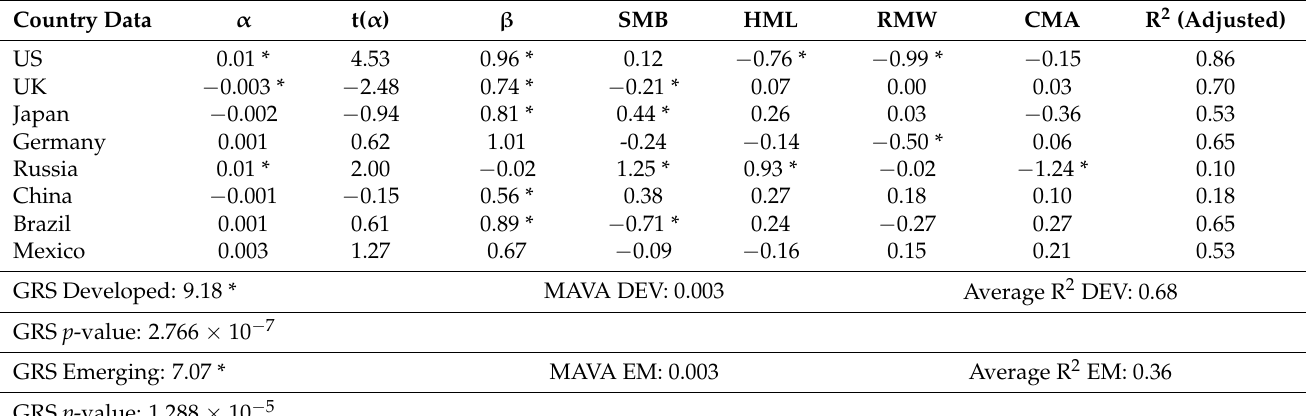
Table 1. Fama French five-factor regressions for country indices—developed and emerging; *: p <